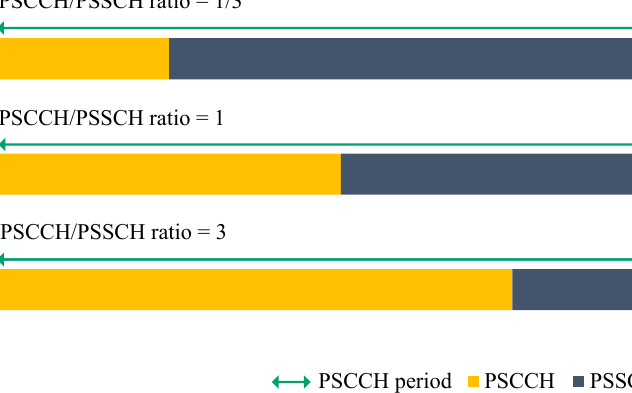
Figure 4. Sidelink channel configurations utilized in the performance